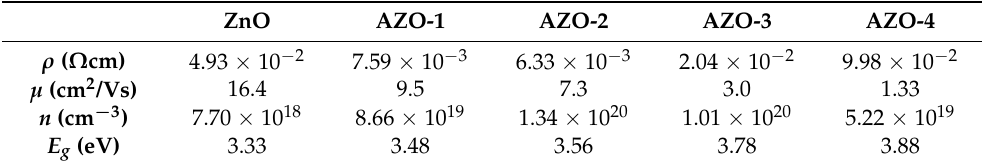
Table 3. Electrical parameters and band gap of ZnO and AZO layers with different Al concentrations, measured at room temperature ( ρ —resistivity; µ —mobility of carriers; n —concentration of electrons; E g —band